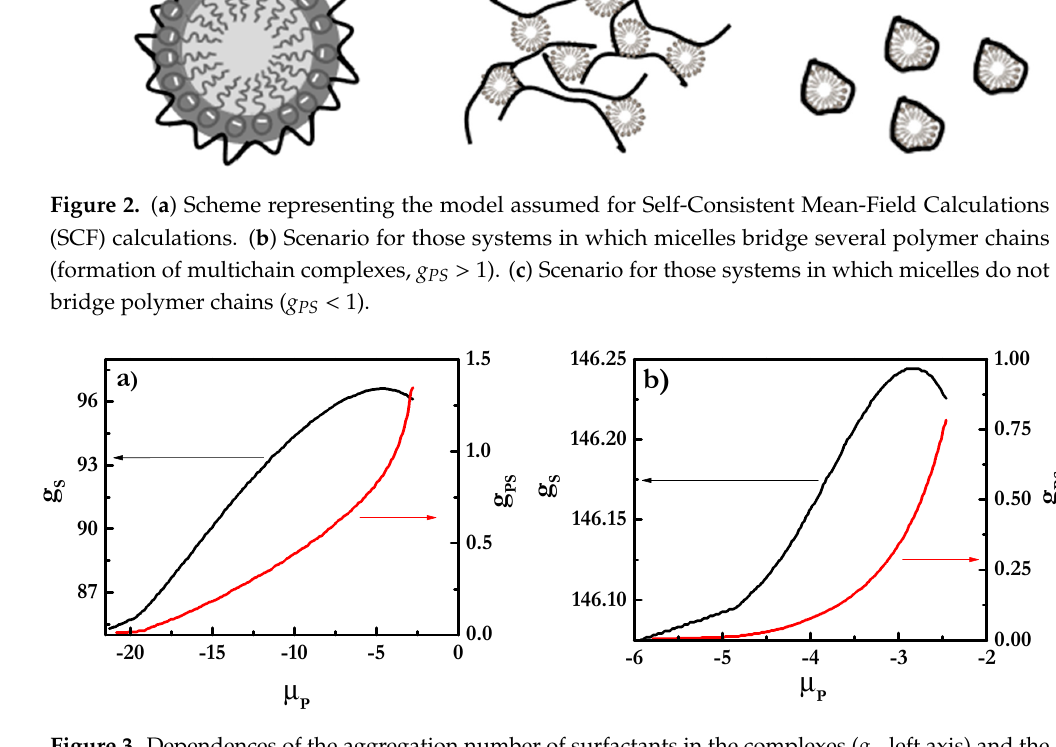
Figure 3. Dependences of the aggregation number of surfactants in the complexes ( g s , left axis) and the degree of polyelectrolyte–surfactant binding ( g PS , right axis) on µ P for mixtures of PDADMAC with SLES ( a ) and with CB ( b ).